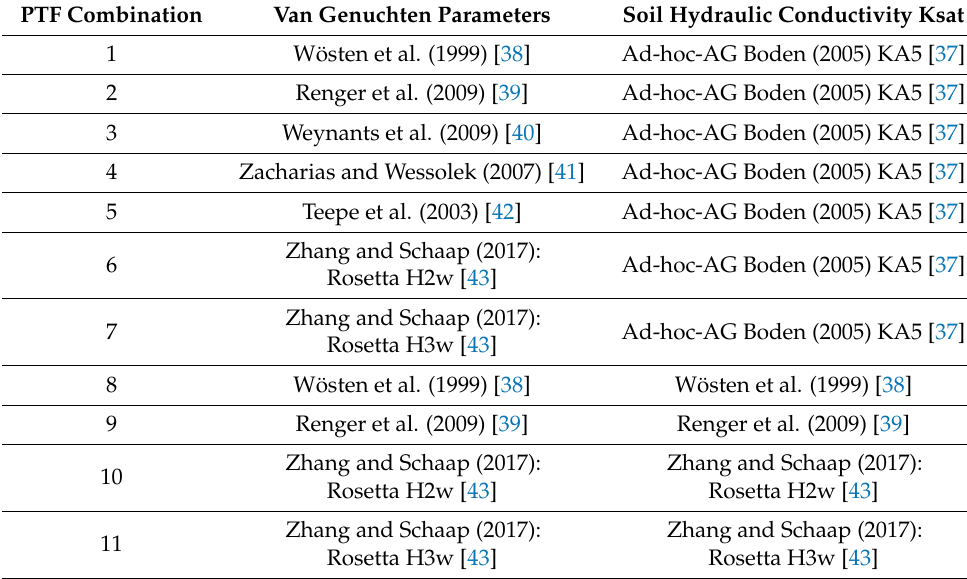
Table 1. PTF combinations to estimate the parameters of van Genuchten ( θ sat, θ res, n) and saturated hydraulic conductivity